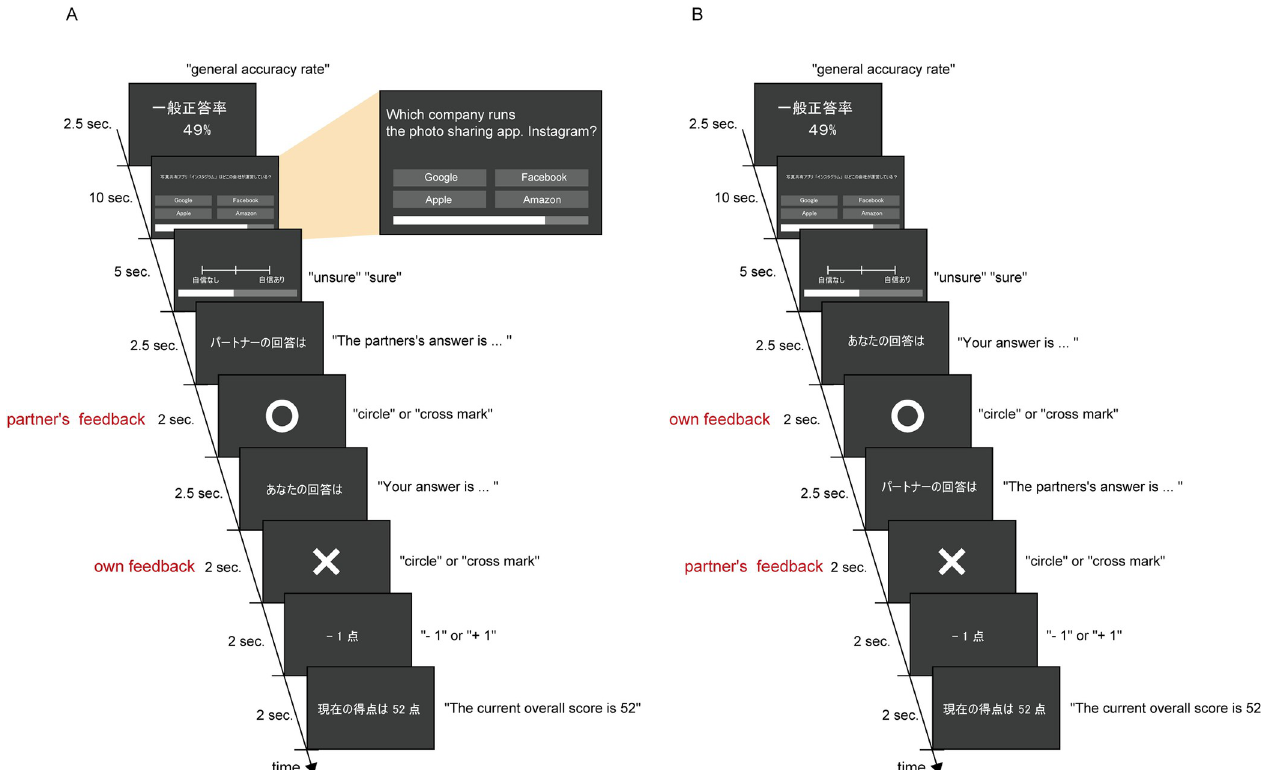
Fig 2. Experimental procedure. The participants paired up and performed a four-choice question task simultaneously. Participants were presented with the question text, the general accuracy rate of the question, and four corresponding choices. After answering, the participant reported the degree of confidence rate for the